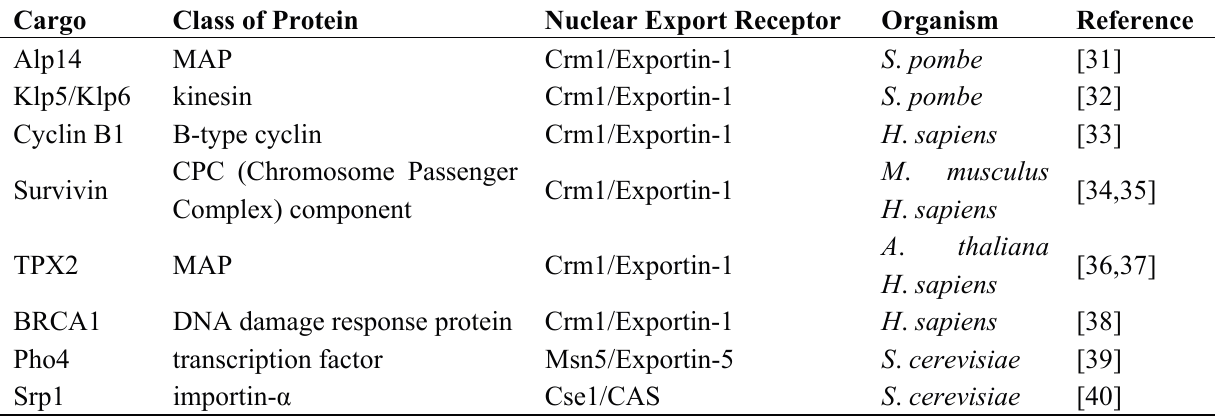
Table 1. Example of cargo exported from the nucleus to the